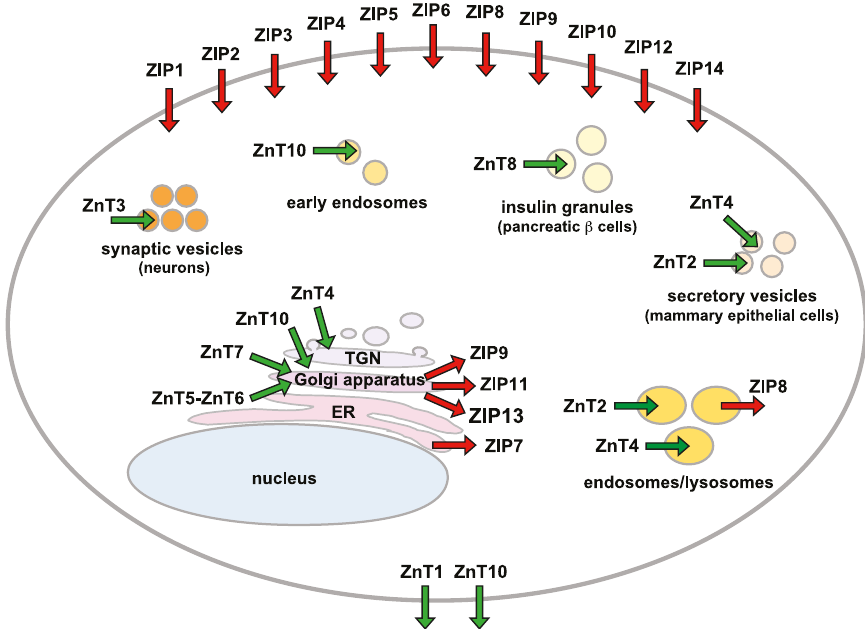
Figure 4. The subcellular localization of ZIP and ZnT transporters. The primary localization of ZIP ( red arrows) and ZnT ( green arrows) transporters is shown according to available information. This schematic illustrates a static view of their localization. Cytosolic zinc is mobilized into or out of different subcellular compartments, including synaptic vesicles or insulin granules in a cell-specific manner. ER, endoplasmic reticulum; TGN, trans -Golgi network.